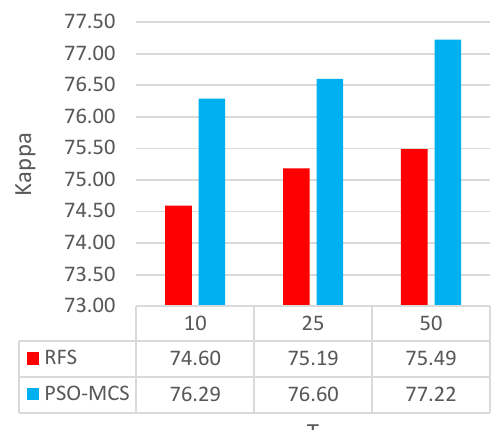
Figure 5. Kappa coefficient vs. ensemble size (